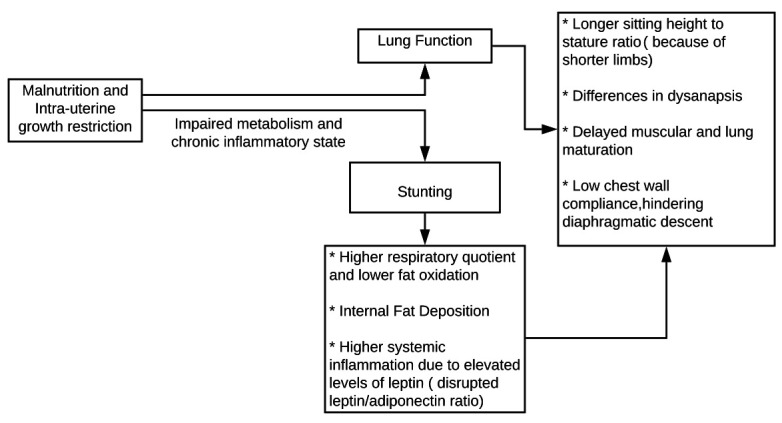
Stunting and restrictive lung function (FVC <80% of predicted) - anthropometric correlates.